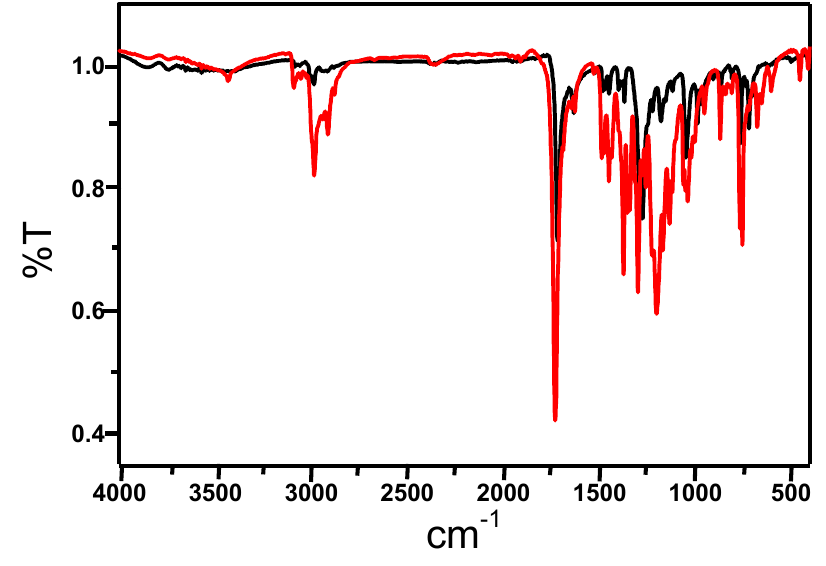
Figure 2. Infrared spectra of DADB (–) and DEADP (–).